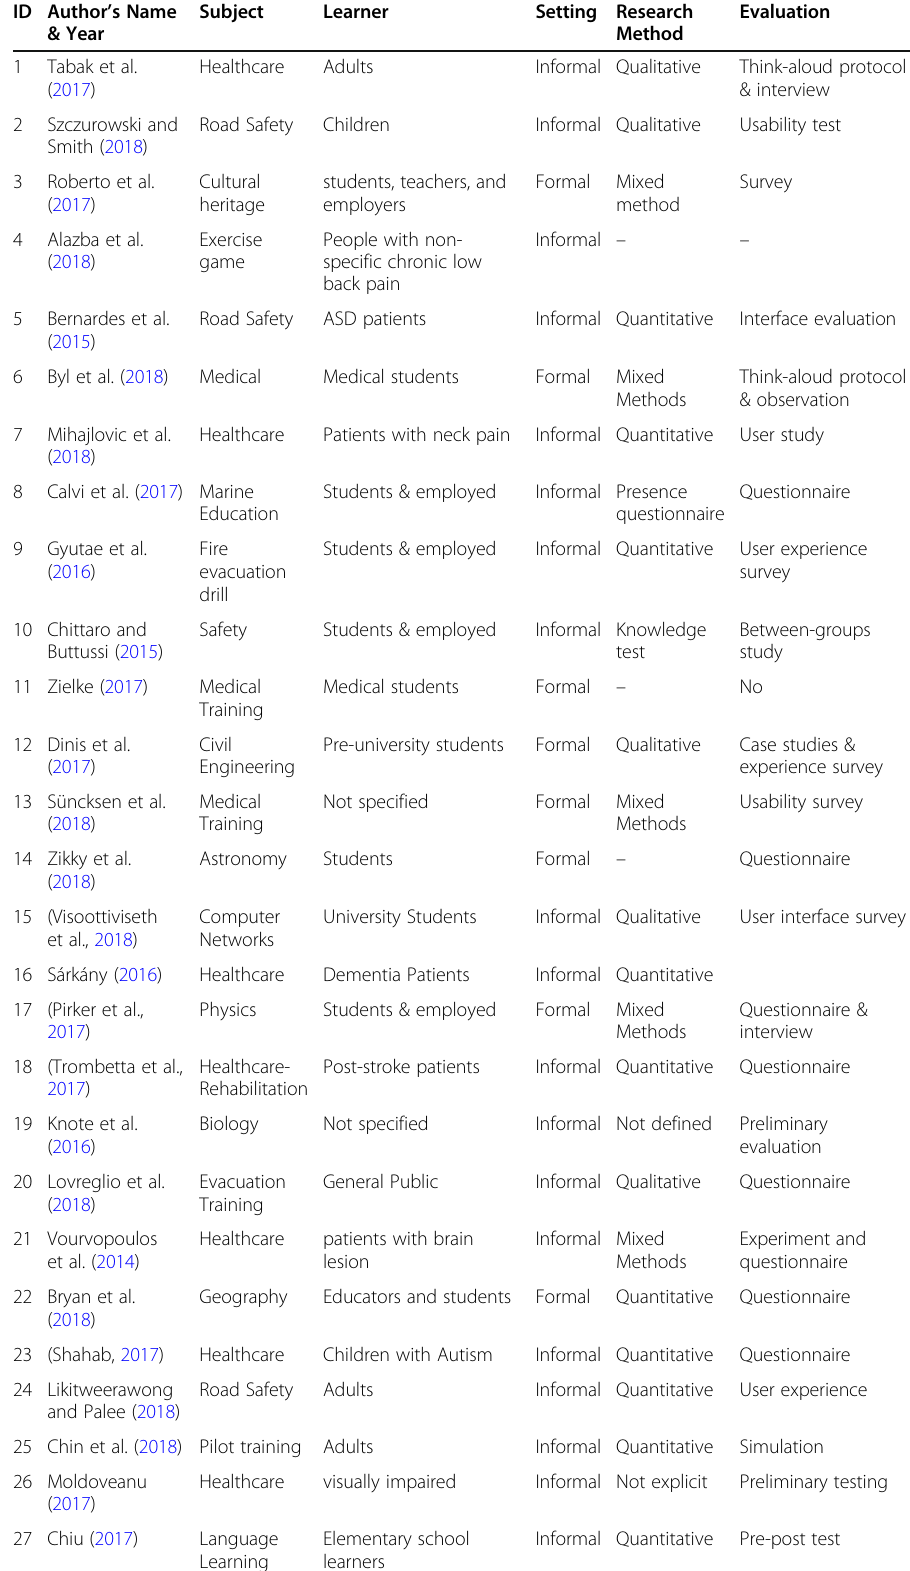
Table 7 Pedagogical characteristics of